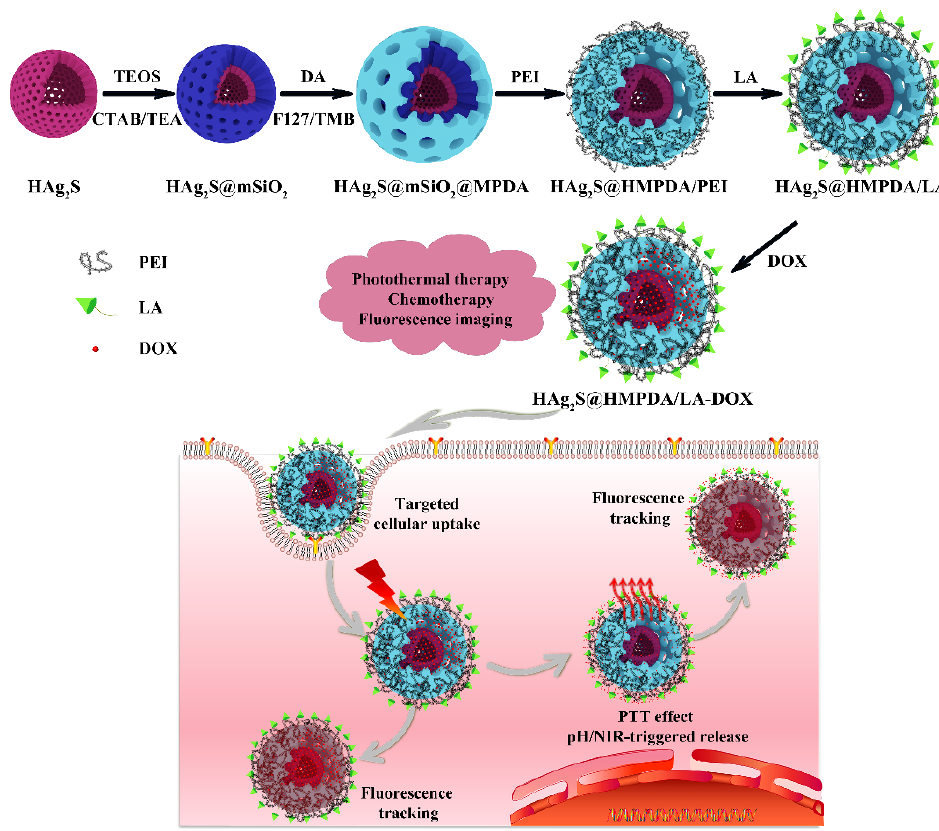
Figure 1. Schematic diagram of the fabrication of multifunctional double-shelled HAg 2 S@HMPDA/LA nanocarriers and their fluorescence-mediated combined photothermal chemotherapy for cancer treatment.